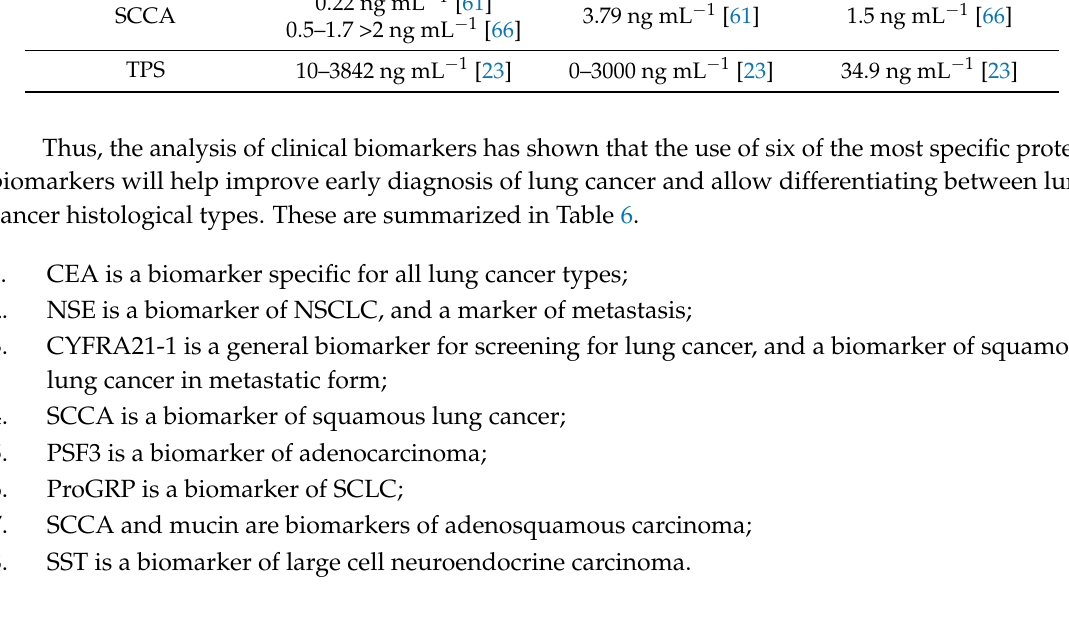
Table 6. A panel of biomarkers specific for SCLC, adenocarcinoma, squamous lung cancer, and large cell lung